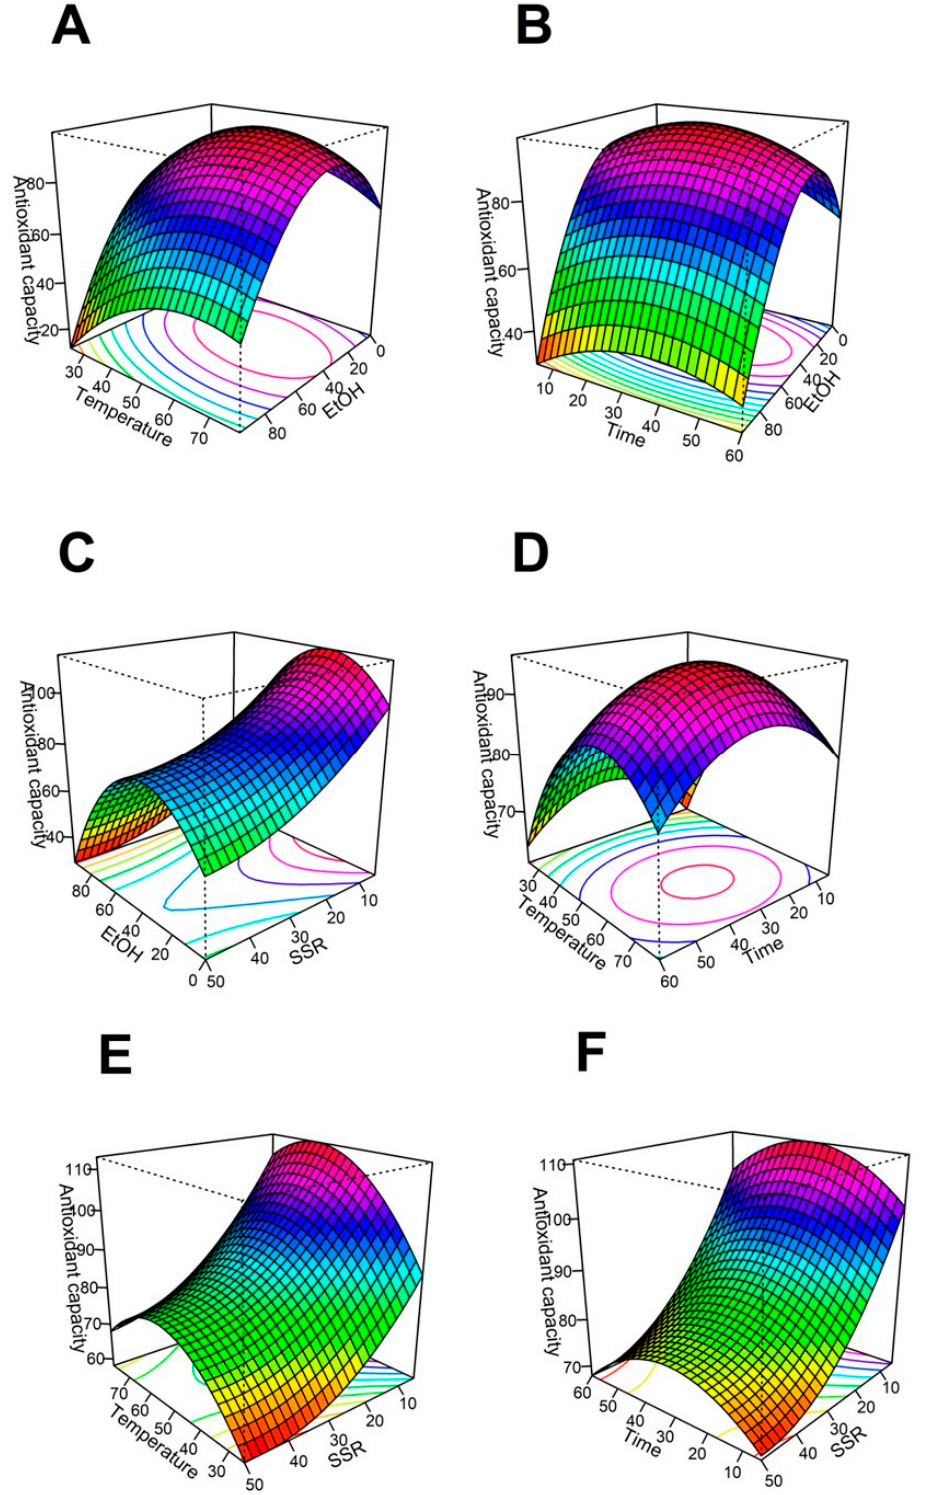
Figure 1. Surface-response analysis of the effect of EtOH (%), Temperature (°C), Time (min), and SSR (g/500 mL) on the antioxidant capacity (µmol TE/gDM). ( A ) SSR vs. EtOH, ( B ) EtOH vs. temperature, ( C ) EtOH vs. Time, ( D ) Time vs. SSR, ( E ) Temperature vs. SSR, and ( F ) Temperature vs. Time. Abbreviations: TE: Trolox equivalents, DM: dry mass, SSR: solid/solvent ratio, EtOH (mass % ethanol in solvent; the remaining percent corresponds to